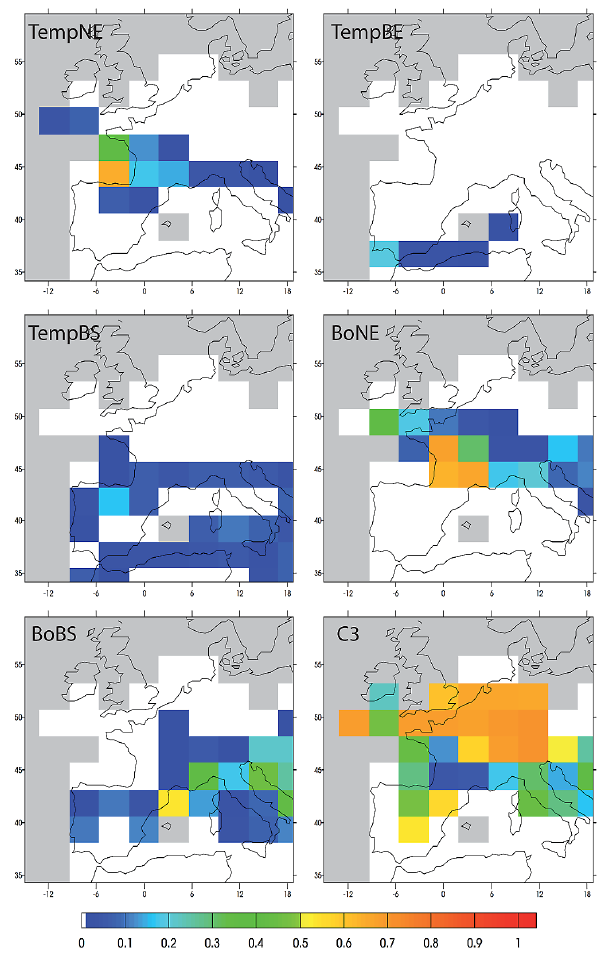
Fig. 11. Vegetation fractions (annual maximum) simulated by OR- CHIDEE at the end of ONtoOFF grad. The values are means over the last 200yr of the run. PFT acronyms: see Table 1. Grey areas are occupied by ocean or ice